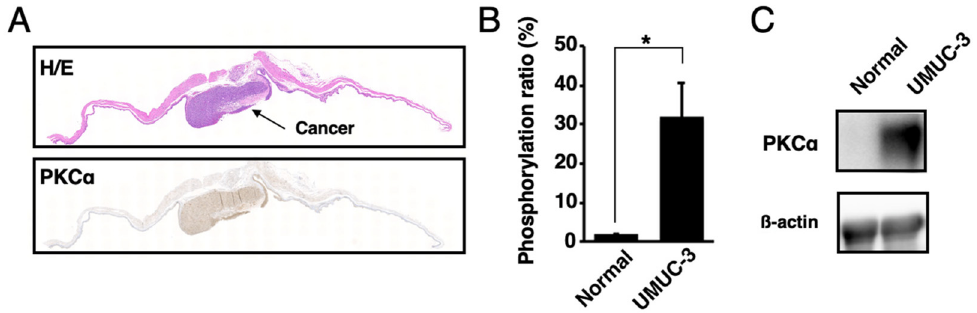
Figure 4. Localization of activated PKC α in bladder cancer tissues and normal bladder tissues. ( A ) Histological analysis of the bladder cancer tissues or normal bladder tissues in the orthotopic xenograft mice with UMUC-3 cells. Tissue sections were stained with hematoxylin–eosin (H/E) and immunohistochemically stained with anti-phosphoPKC α . ( B ) Phosphor- ylation ratios and ( C ) Western blot analysis of the lysates from bladder cancer tissues or normal bladder tissues (n = 3). * p <